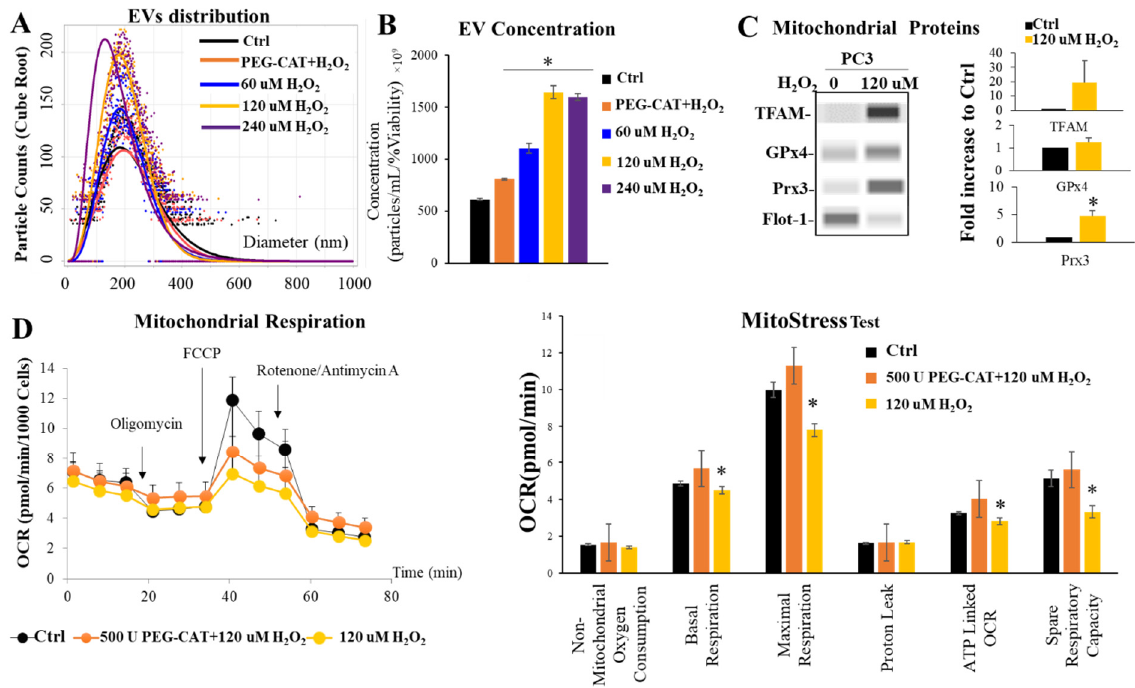
Figure 7. H 2 O 2 - mediated EV release and impaired mitochondrial function. ( A ) Size distribution of EVs derived from PC3 cells treated with H 2 O 2 . Margin Model from negative binomial overlaid with observed values (Predict values without random effects). ( B ) Concentration of EVs that derived from PC3 cells treated with H 2 O 2 . ( C ) Cargo of EVs that derived from PC3 cells treated with H 2 O 2 . Bar graphs indicate average fold changes in protein expression compared to control (Ctrl) (from at least three separate experiments). * p -value < 0.05. ( D ) Seahorse mitochondrial stress test of PC3 cell line after treatment of 120 µM of H 2 O 2 . PEG-CAT was used in combination with 120µM H 2 O 2 as control for all experiments. * p -value < 0.05 when compared ctrl and PEG-CAT.